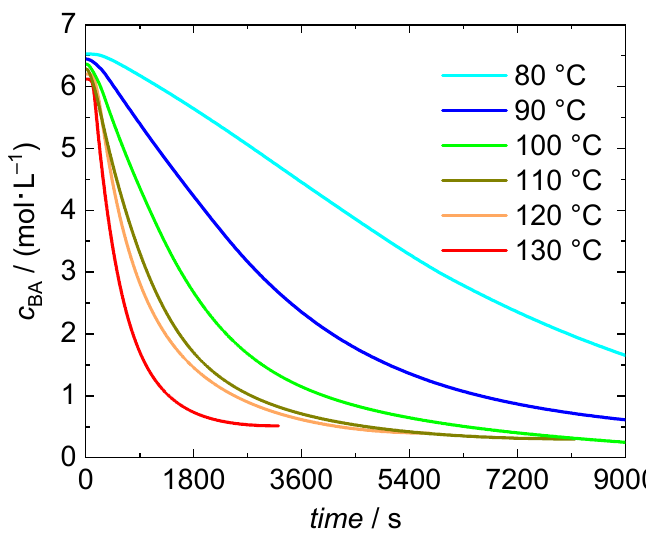
Figure 2. Concentration vs. time data for BA bulk polymerizations at temperatures between 80 °C and 130 °C with in-line DSC measurement. The timestamp with value 0 is set at the time at which the polymerizations starts. The integration of the DSC data starts at this time, too.